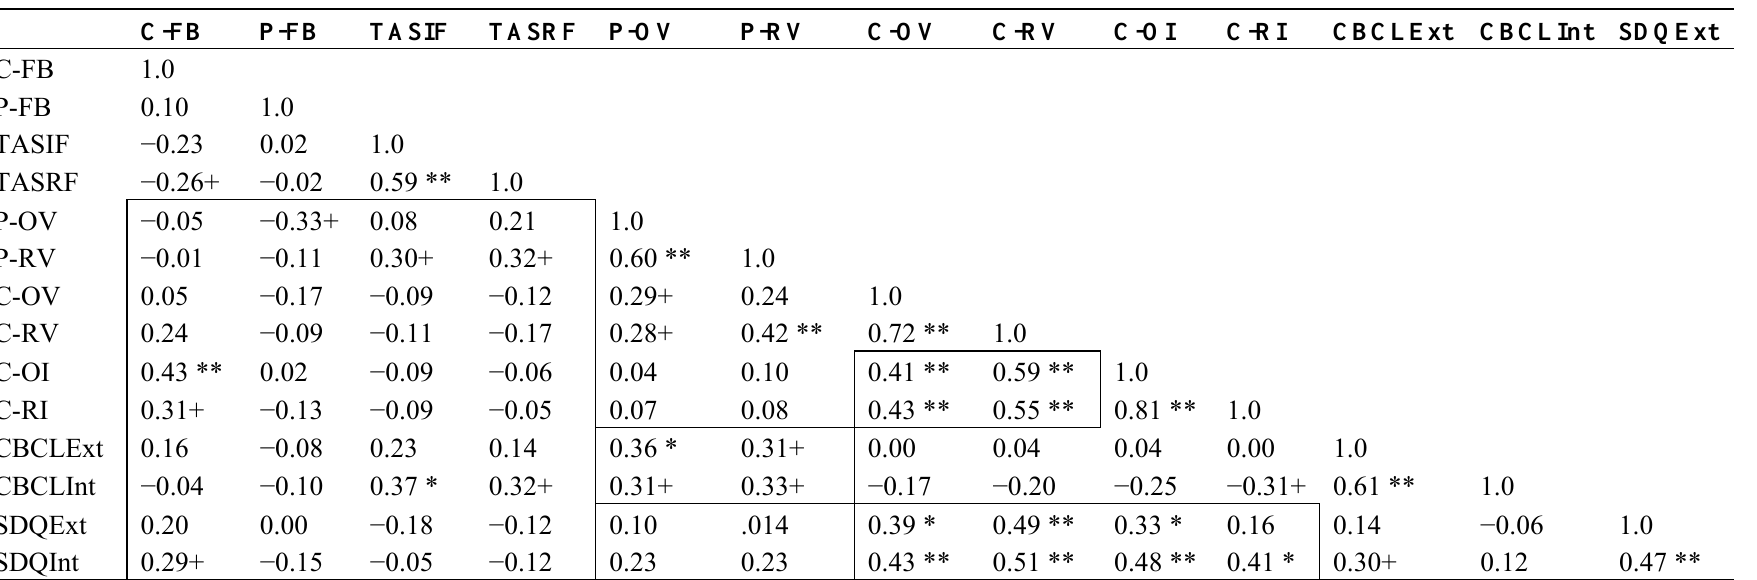
Table 2. Intercorrelations among Study